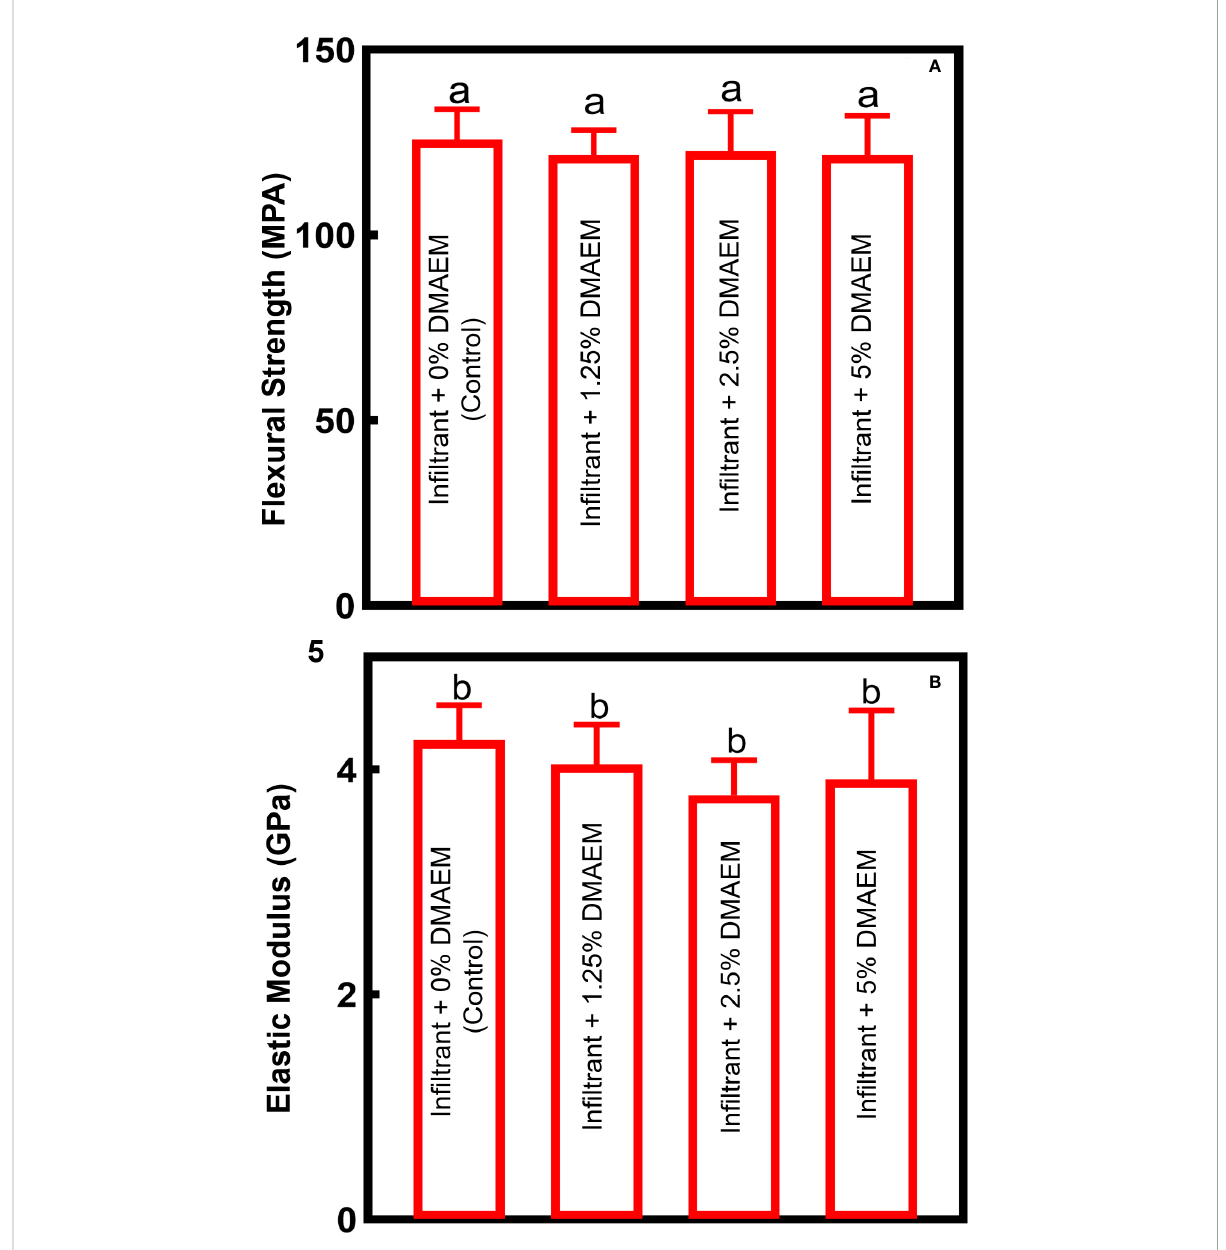
FIGURE 3 Mechanical properties of DMAEM resin in fi ltran. (A) The fl exural strength, (B) the elastic modulus (mean ± SD; n = 6). The different letters indicate the signi fi cant difference between the bars (a, b, c), there were no signi fi cant difference among the four groups (p >